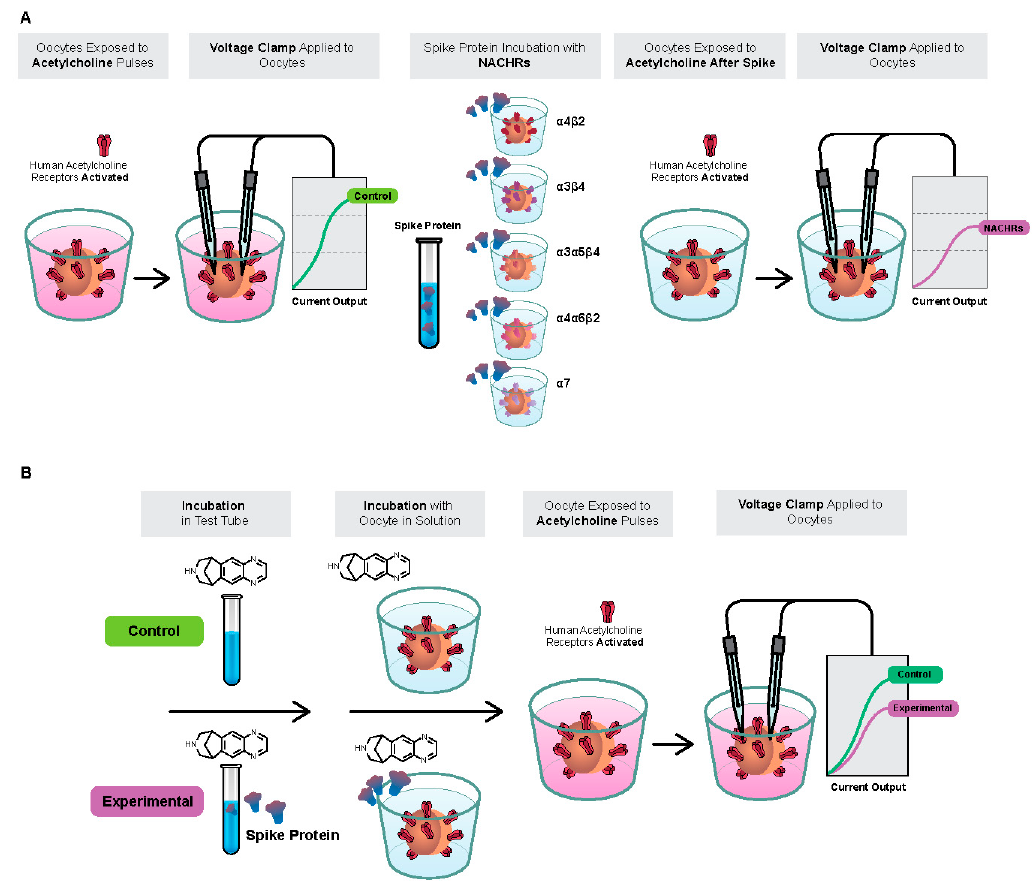
Figure 13. ( A ) Experimental protocol to assay effects of spike protein containing the receptor- binding domain (Spike-RBD) with human nicotinic acetylcholine receptor (nAChR) subtypes. ( B ) Experimental protocol to assay effects of varenicline with Spike-RBD at human α 4 β 2 nAChRs.